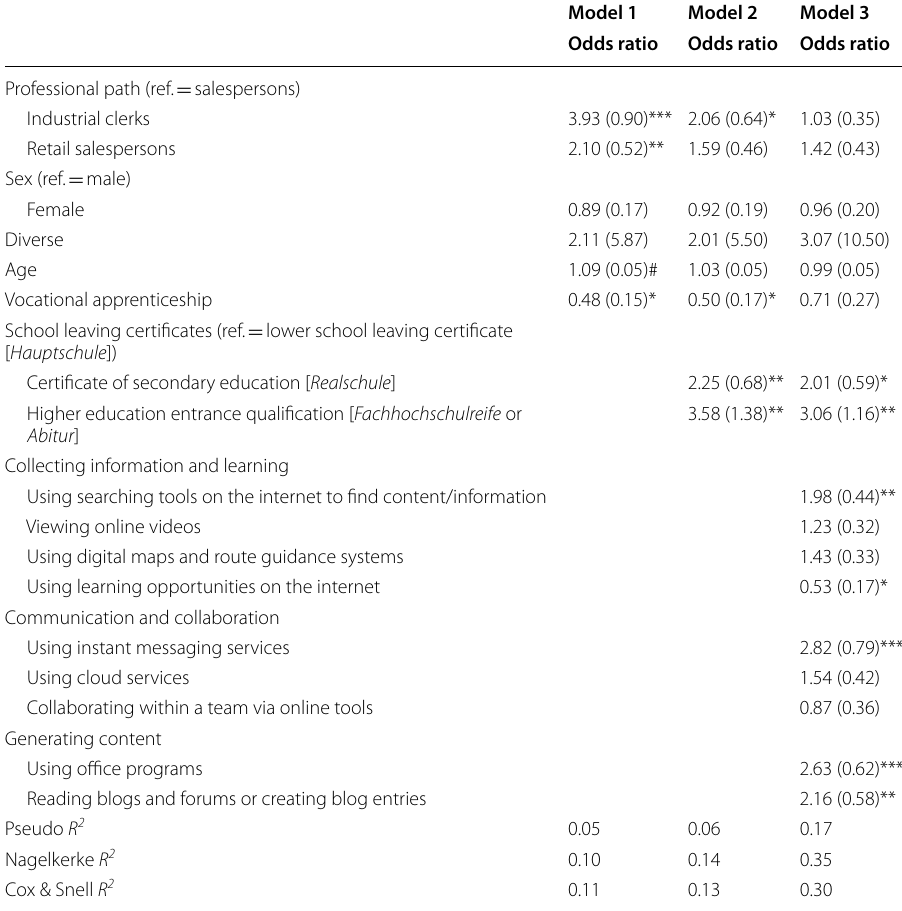
Table 6 Ordinal regression of digital competence profile with 500 bootstraps ( n